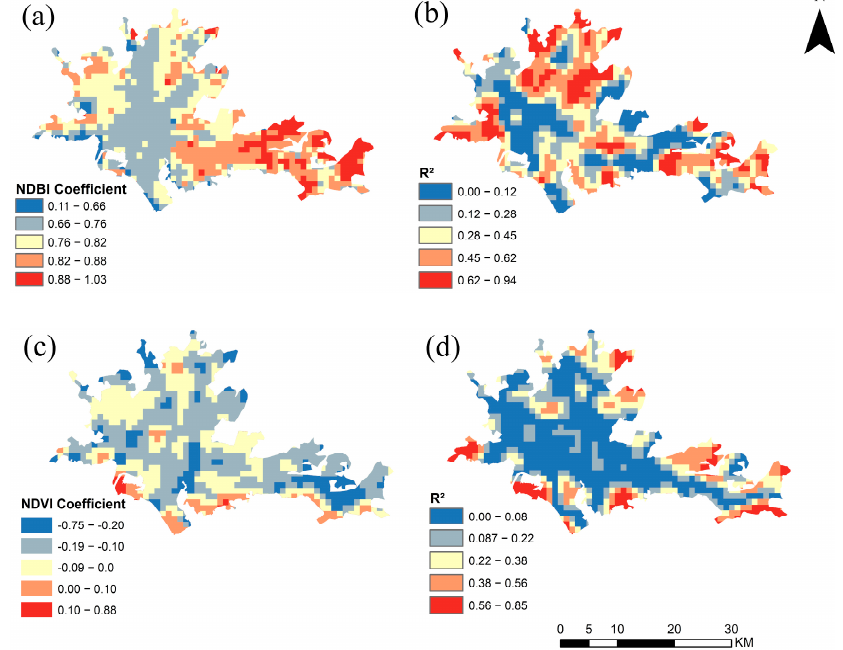
Figure 10. Results of the GWR analysis: correlation coefficients between the NLST and ( a ) the NDBI and ( b ) the corresponding local R 2 and correlation coefficients between the NLST and ( c ) the NDVI and ( d ) the corresponding local R 2 .